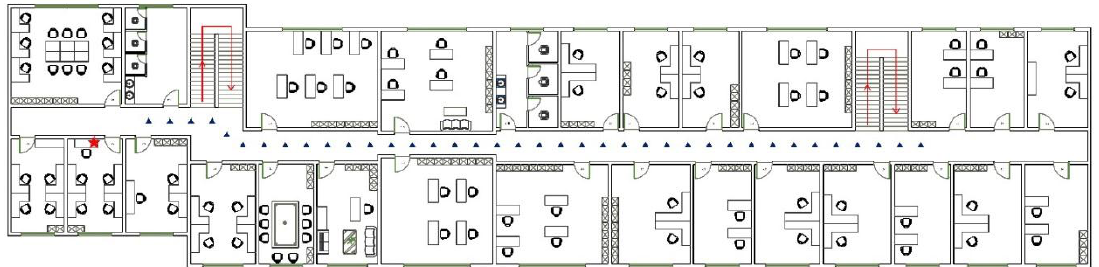
Figure 1. “Quasi-dynamic” Wi-Fi signal experimental indoor layout.